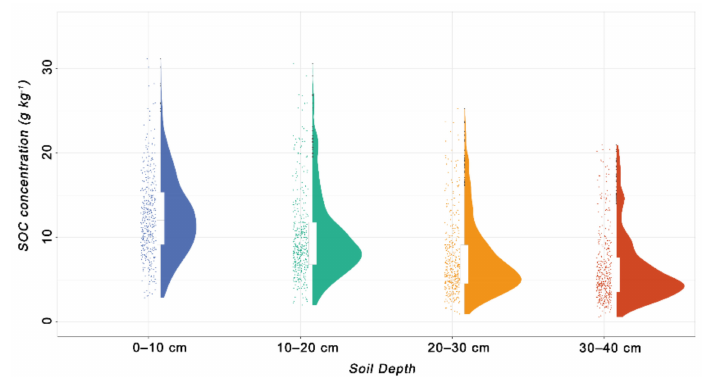
Figure 2. Raincloud plot of SOC concentration in four